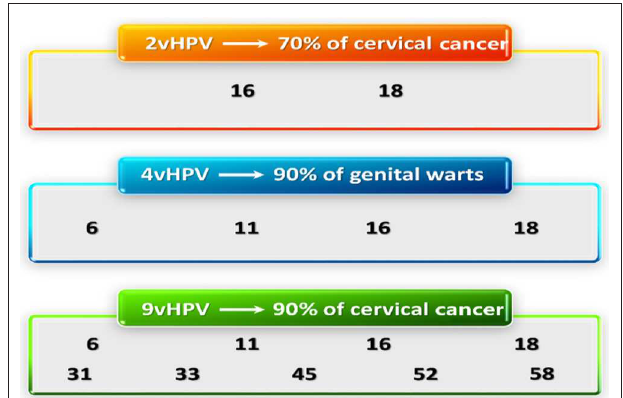
FIGURE 3 | HPV VLP types in VLP vaccines. VLPs in the 2vHPV, 4vHPV, and the 9vHPV are shown with the proportion of neoplastic disease attributed to each group. HPV, human papillomavirus; VLP, virus-like